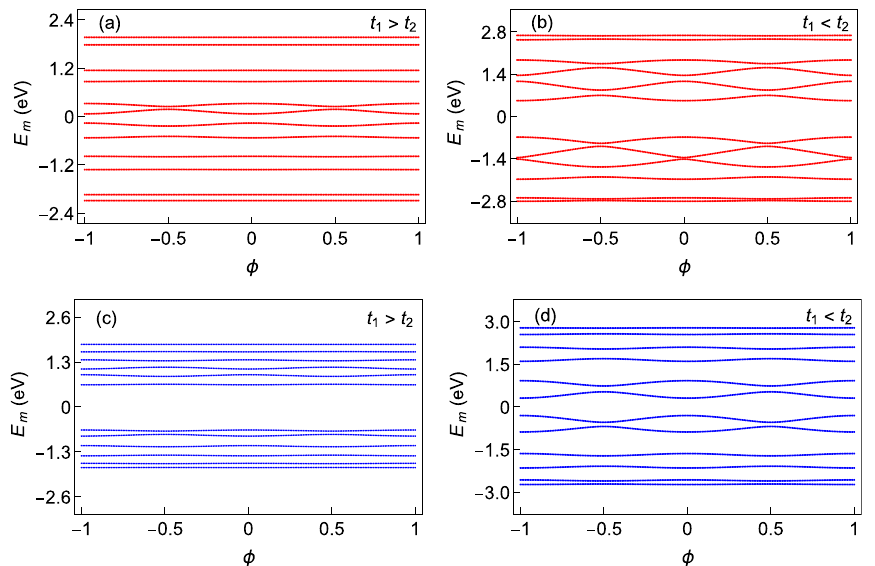
Figure 3. Dependence of energy eigenvalues as a function of AB flux φ for the AAH SSH rings at AAH disorder strength W = 1 , where first and second rows denote the results for the non-staggered and staggered cases, respectively. The values of N , φ ν , t 1 and t 2 for t 1 < t 2 and t 1 > t 2 remain same as taken in Fig. 2, for a clear comparison of the energy